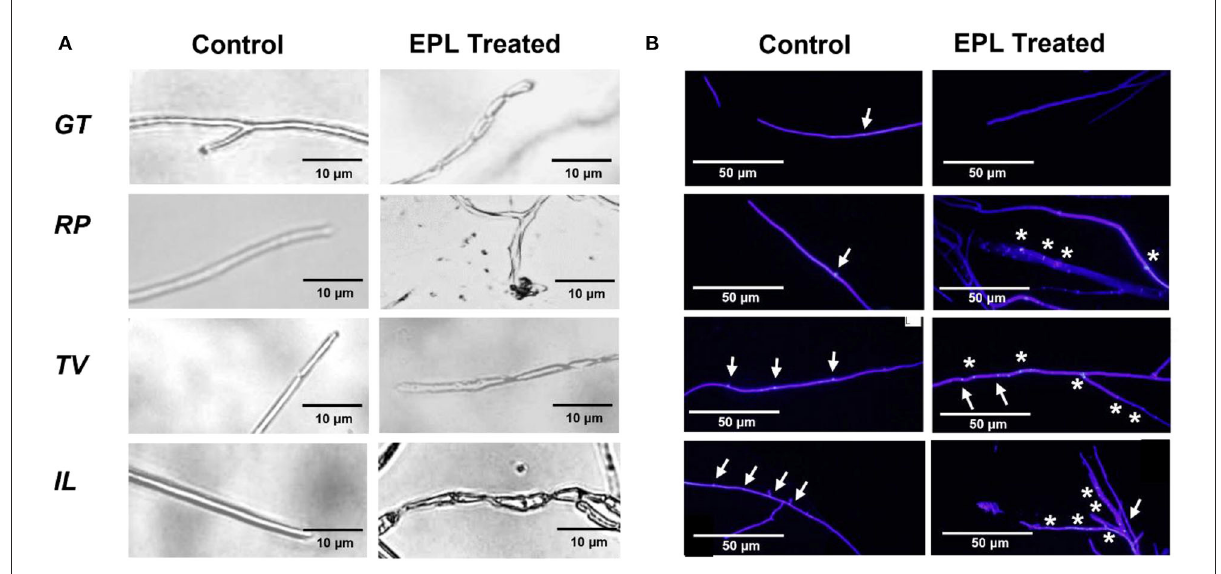
FIGURE3 (A) Optical micrographs showing morphological changes of the hyphae before and after the EPL treatment and (B) fluorescent micrographs of four fungi, GT, RP, TV, and IL ; intact nuclei are indicated by arrowheads ( ↑ ), while fragmented nuclei are indicated by *. The actively growing fungal tips were exposed to the control malt agar substrate or amended with 1 mg/ml EPL for GT, 3 mg/ml EPL for RP, and 2 mg/ml EPL for both TV and IL.